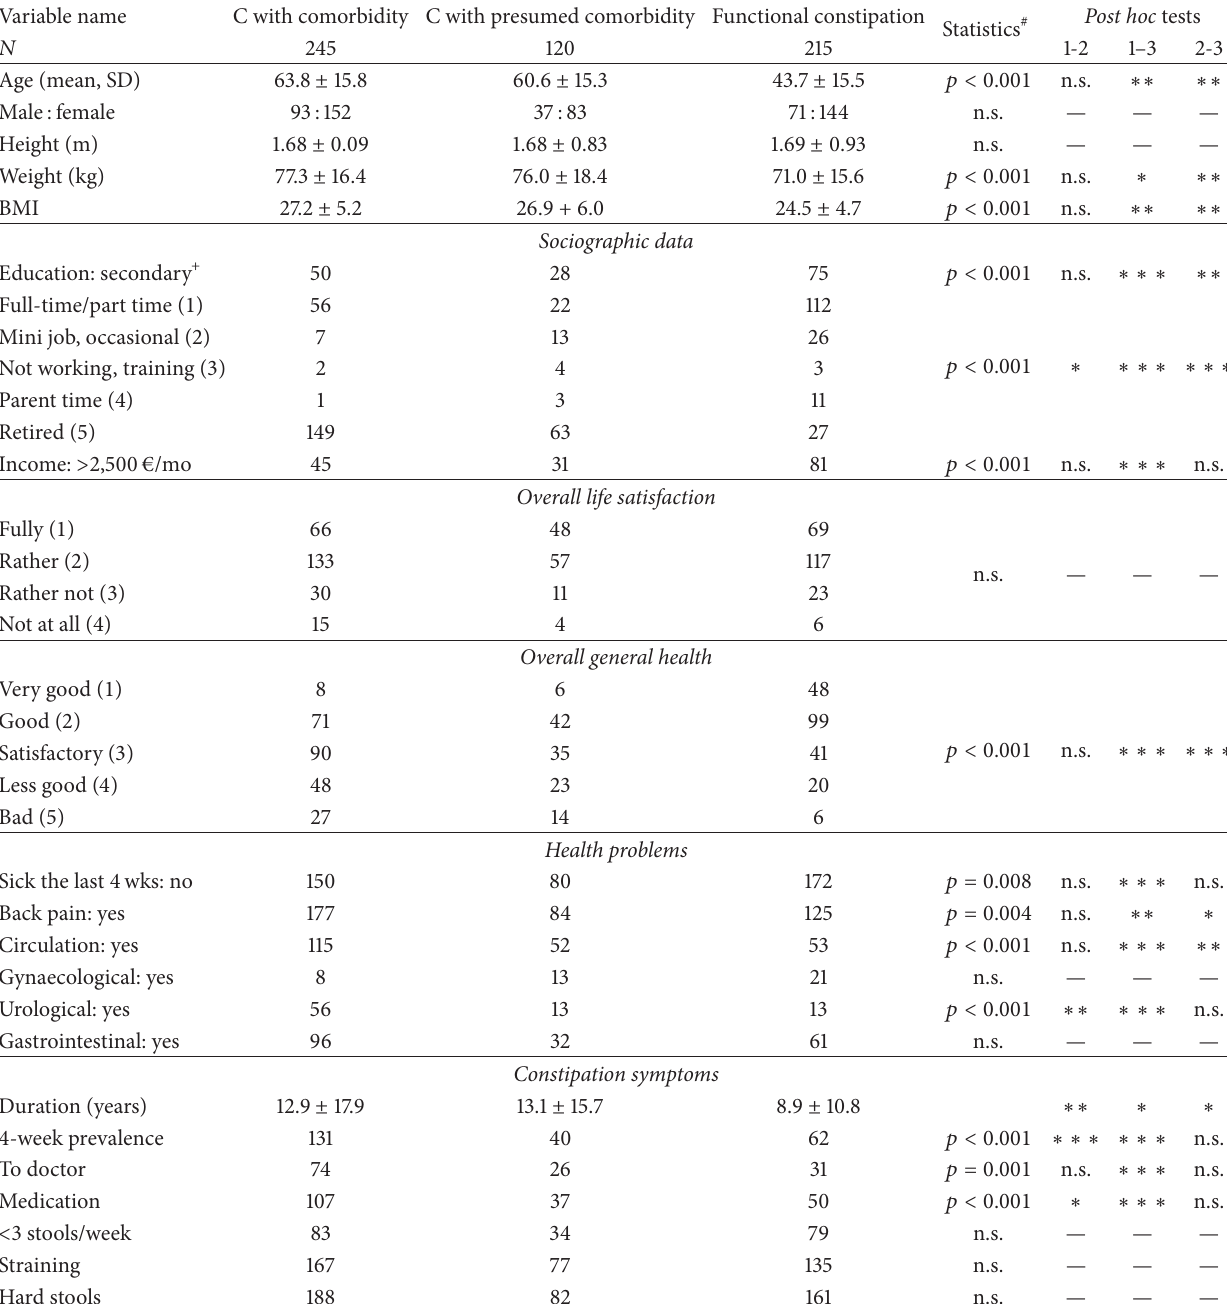
Table 2: Sociographic data, health problems, and life satisfaction in comorbid constipation ( 𝑛 = 245 ) as compared to constipated individuals with regular medication (presumed comorbidity) ( 𝑛 = 120 ) and without comorbid condition (functional constipation) ( 𝑛 = 215